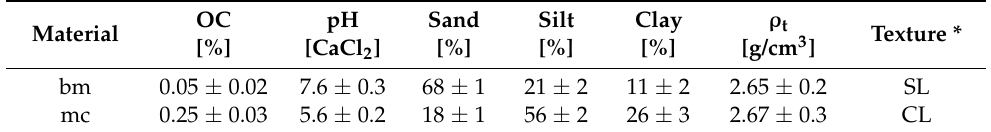
Table 1. Basic soil characteristics of the landfill capping system for marsh clay (mc) and boulder marl (bm), n = 4 repeated measurements for organic carbon (OC), pH value, texture, and particle density ( ρ s). The symbol ± corresponds to the standard deviation. SL = CL = * [28].